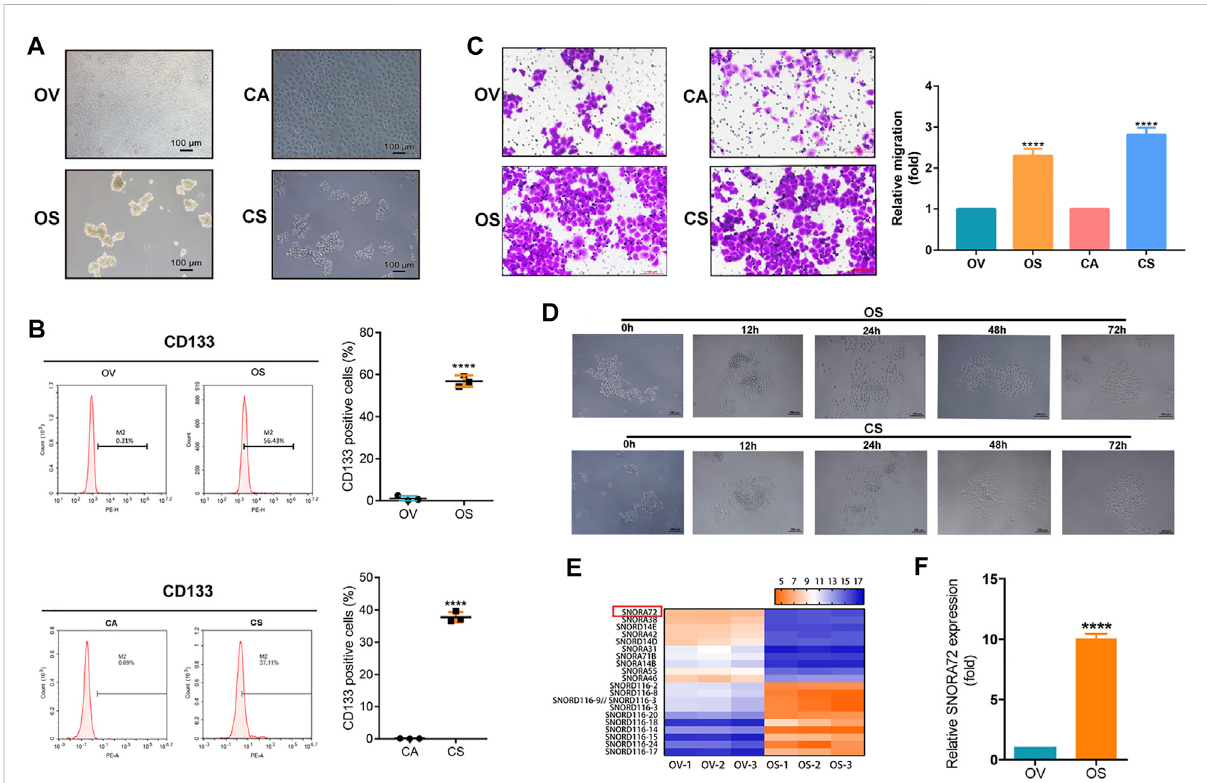
SNORA72 is overexpressed in ovarian cancer stems cells (OCSCs). (A) Morphology of OVCAR-3 (OV), OVCAR-3 spheroid (OS), CAOV-3 (CA), and CAOV-3 spheroid (CS)cells shown under amicroscope(×10). (B) Expression of CD133 detected by fl owcytometryinOVvs. OS and inCA vs.CS cells. (C) MigrationabilitiesofOV,OS,CA,andCScellsbyTranswellassay. (D) DifferentiationmorphologyofOSandCScellsat0,12,24,48,and72 h. (E) HierarchicalclusteringanalysisofsmallnucleolarRNA(snoRNA)expressionfromnon-codingRNA-ChIPdatainOVandOScells.Red,higher expressionlevels;green,lowerexpressionlevels. (F) RelativeSNORA72expressiontoU6,asanendogenouscontrol,analyzedbyqRT-PCRinOVand OScells.TheSNORA72expressioninOVcellswassetas1.Dataareshownasthemean±SDfromthreeindependentexperiments.** p < 0.01,**** p <